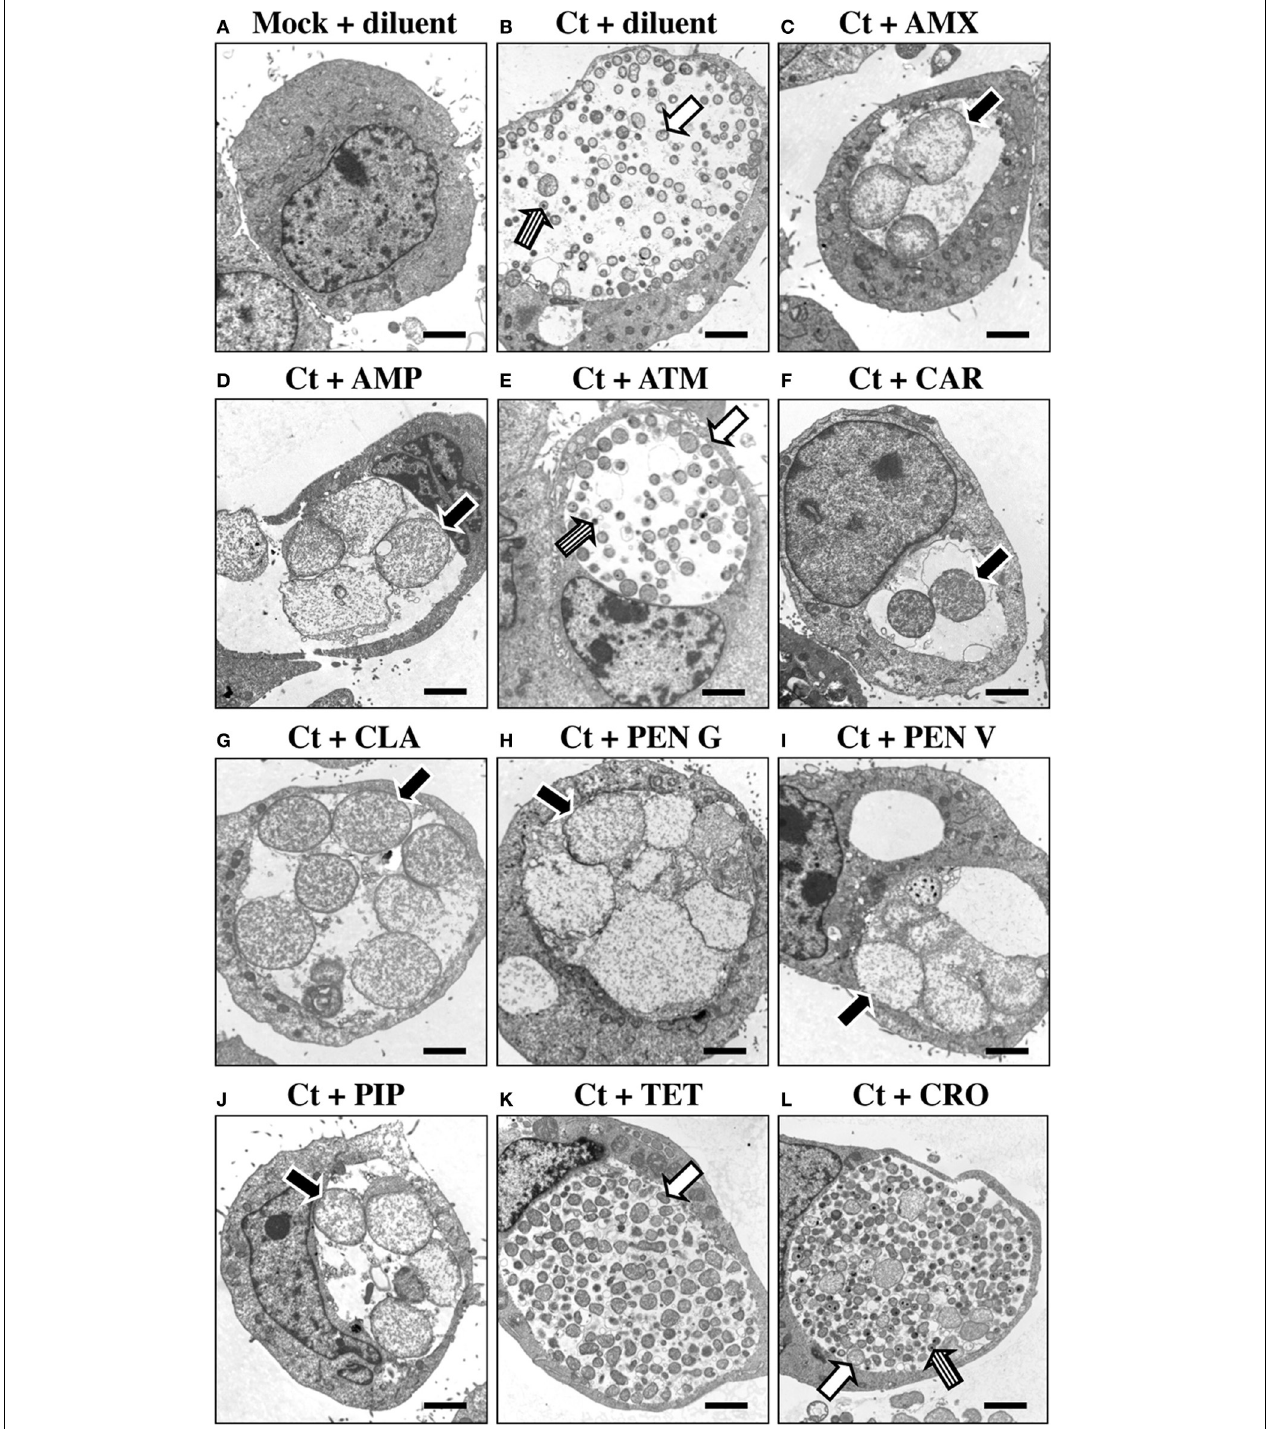
C. trachomatis + AMP. (E) C. trachomatis + ATM. (F) C. trachomatis + CAR. (G) C. trachomatis + CLA. (H) C. trachomatis + PEN G. (I) C. trachomatis + PEN V. (J) C. trachomatis + PIP. (K) C. trachomatis + TET. (L) C. trachomatis + CRO. Morphologically normal RB and EB are indicated by white and striped arrows respectively. Abberent bodies (AB) are labeled with black arrows. Each photomicrograph is at 7500X magnification; the black bar at the lower right of each panel represent 2 μ